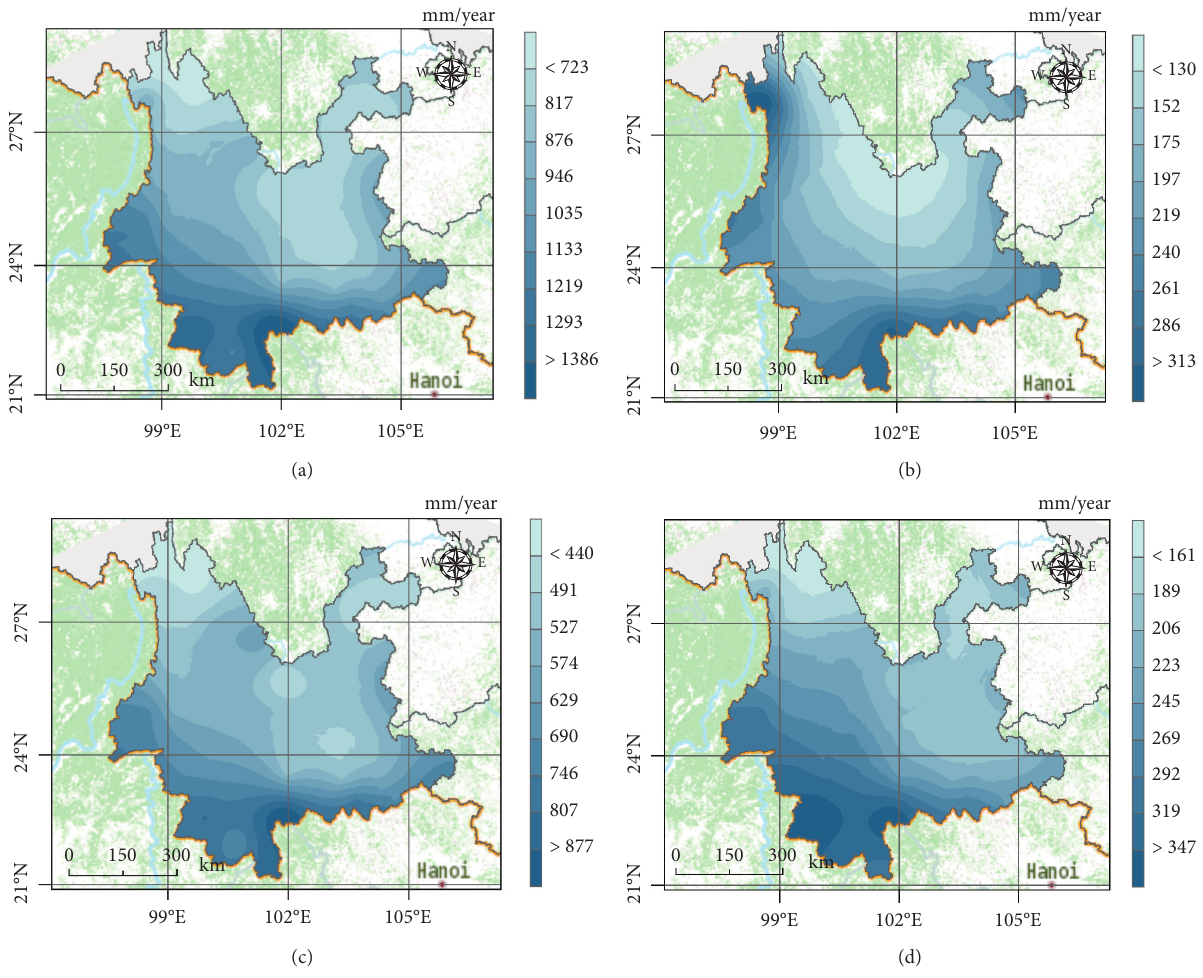
Figure 6: Spatial pattern of multiyear mean precipitation in (a) growing season; (b) spring; (c) summer; (d)